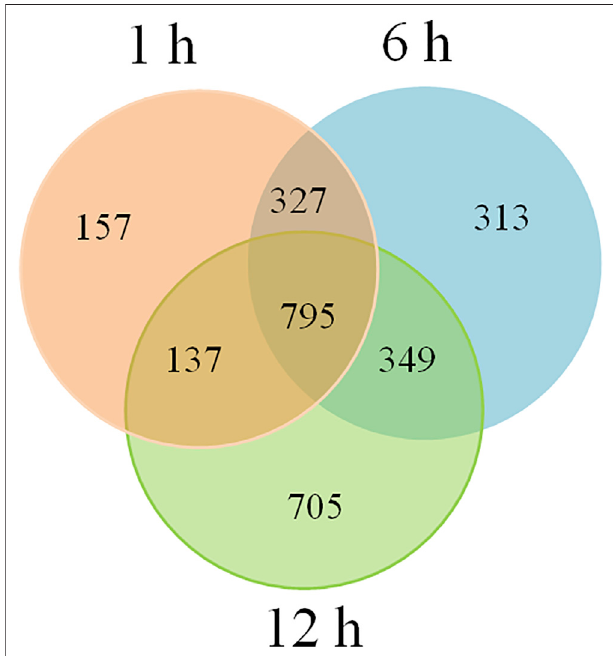
FIGURE 5 | Potential target genes of DE-siRNAs in fl owering Chinese cabbage under heat stress.